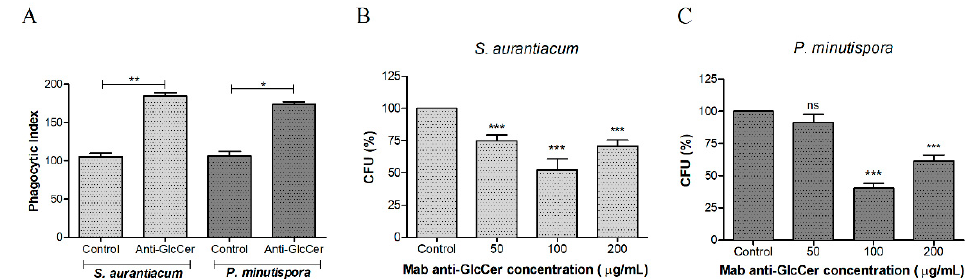
Figure 4. Influence of the anti-GlcCer (Glucosylceramide) Mab (monoclonal antibody) on the phagocytosis of conidia cells by peritoneal macrophages. ( A ) S. aurantiacum and P. minutispora conidia (10 6 ) were incubated with 50, 100, and 200 ug/mL of Mab anti-GlcCer at 37 °C for 1 h. Fungal cells treated with anti-GlcCer MAb were more efficiently internalized, as demonstrated by the phagocytic indices. The phagocytic index values represent the mean ± S.D. of three independent experiments performed in triplicate. ( B,C ) The microbial killing of S. aurantiacum ( B ) and P. minutispora ( C ) by macrophages was enhanced after treatment with anti-GlcCer Mab. CFU: colony forming units. * p < 0.05, ** p < 0.03, *** p < 0.001.